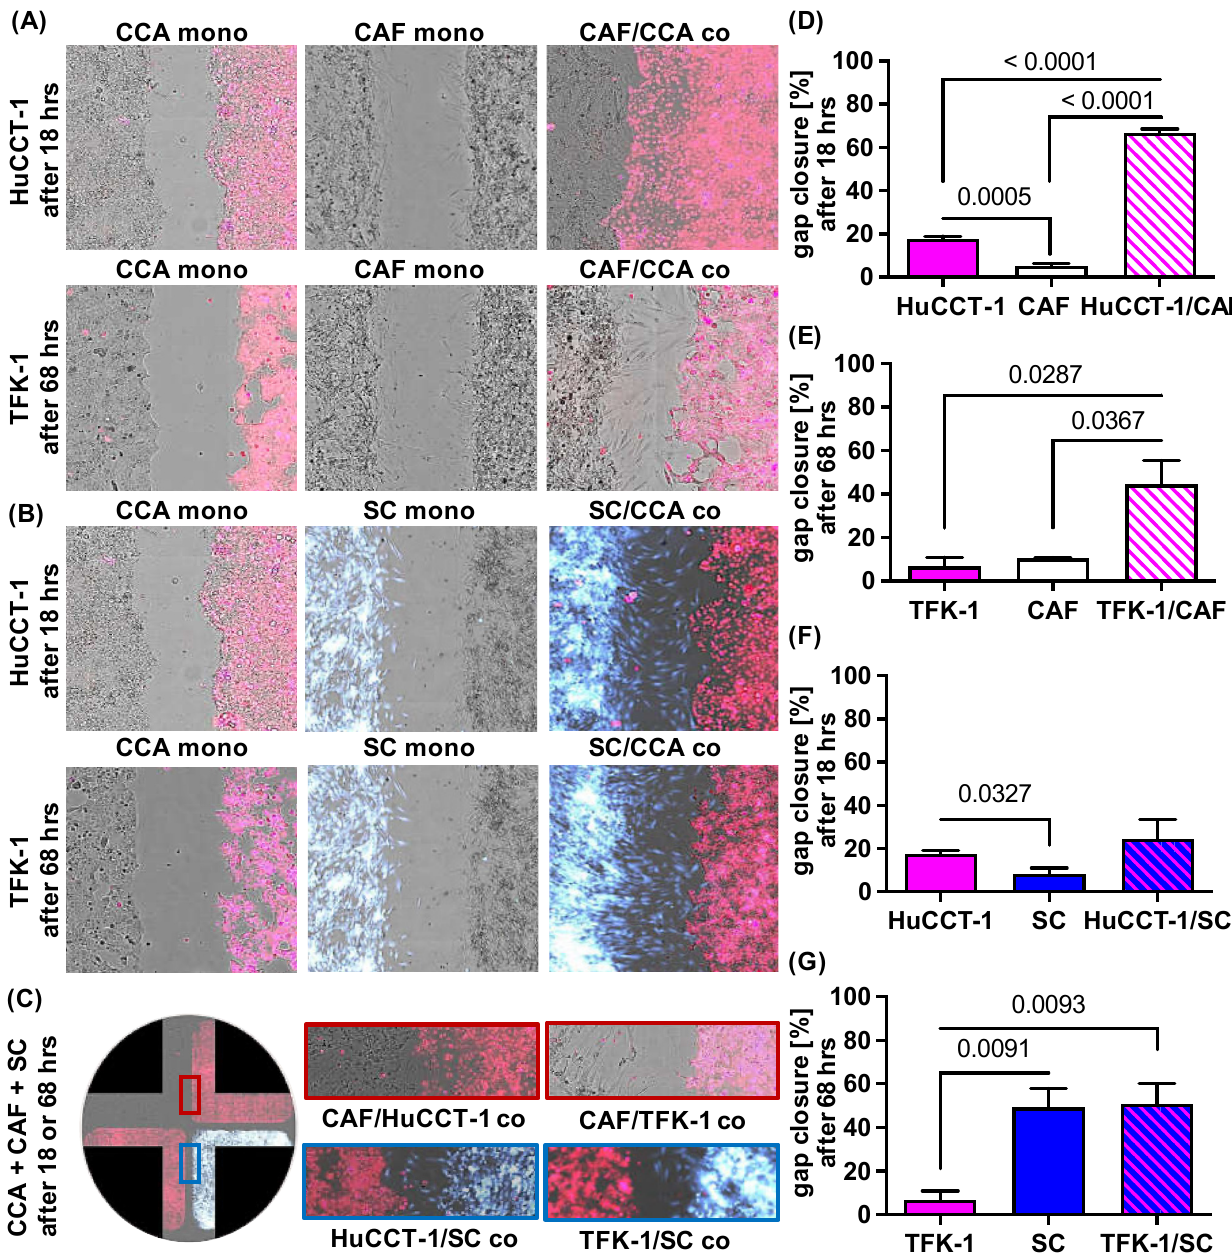
Figure 2. Paracrine impact of CAF and SC on cell migration of CCA cells. HuCCT-1 and TFK-1 cells were cultured either alone (CCA mono) or together with CAF (CAF/CCA co) or SC (SC/CCA co)